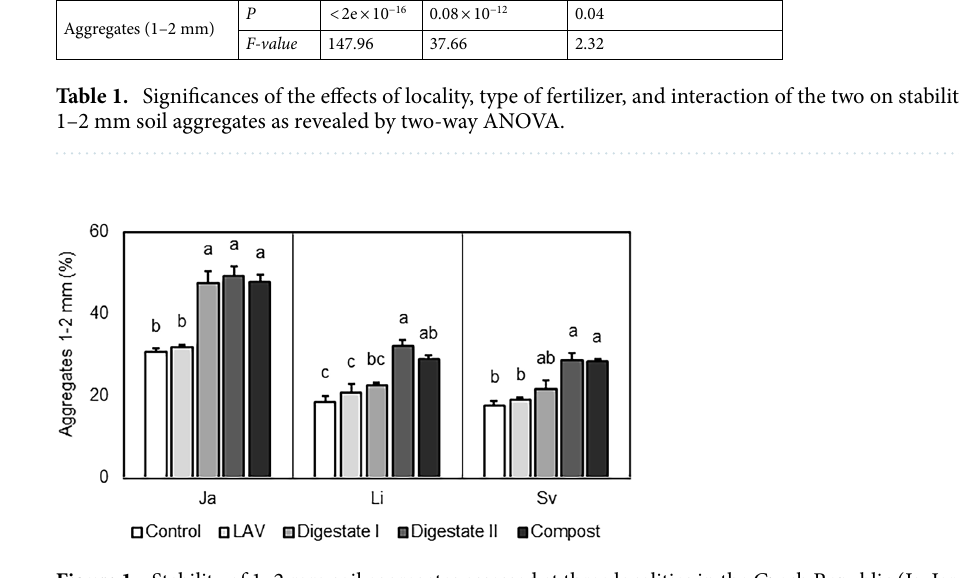
Figure 1. Stability of 1–2 mm soil aggregates assessed at three localities in the Czech Republic (Ja, Jaroměřice nad Rokytnou; Li, Lípa; Sv, Hradec nad Svitavou) as affected by fertilizer types (control, non-fertilized soil; LAV; digestate I; digestate II; compost). Bars represent means; whiskers show standard errors (n = 4). Different letters above individual bars indicate significant differences between means at p < 0.05 within the